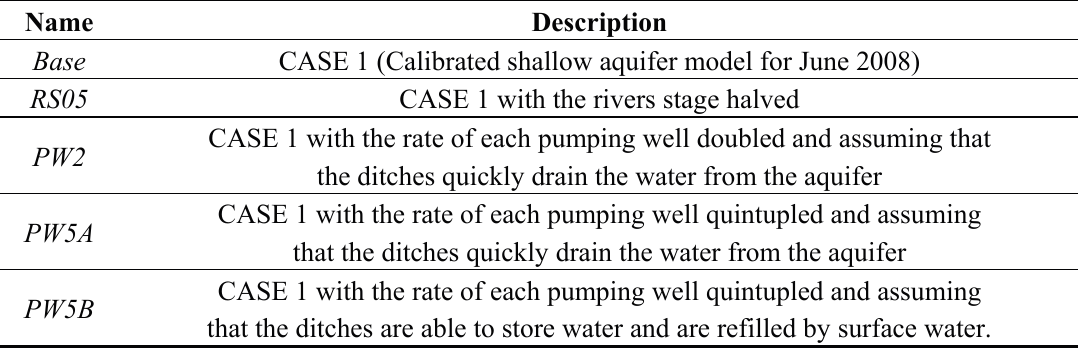
Table 3. Summary of the main features of the investigated